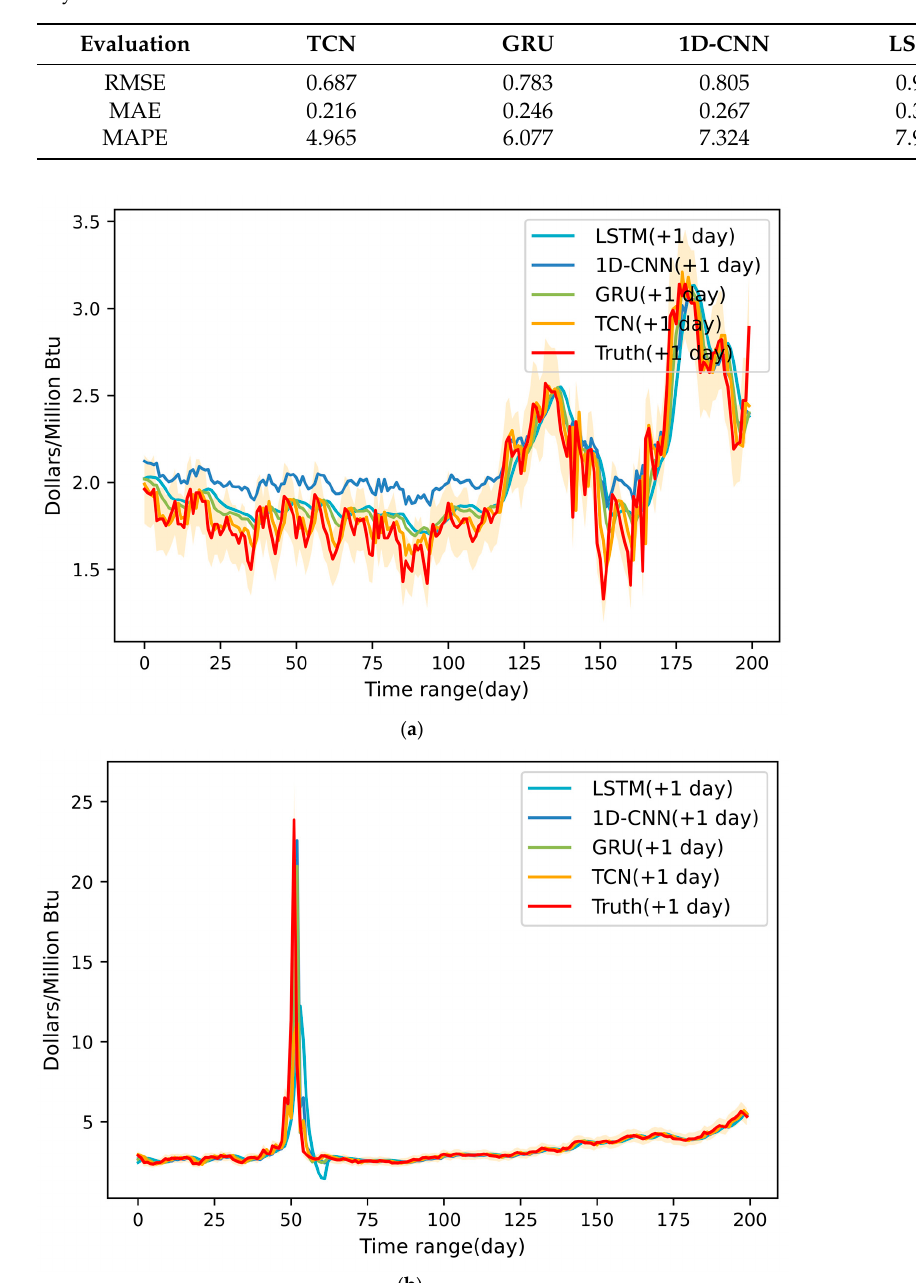
Table 2. Comparison of multi-step prediction performances (MAPE) and elapsed time of several models.